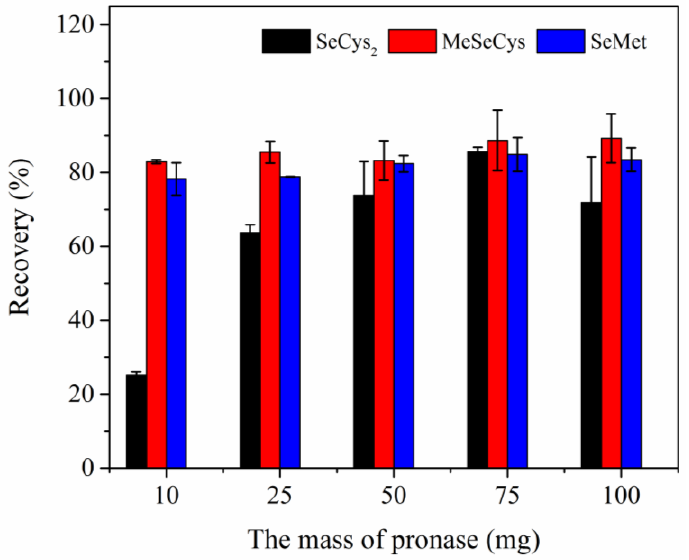
Figure 3. Spike recoveries of three Se species with different pronase usage.